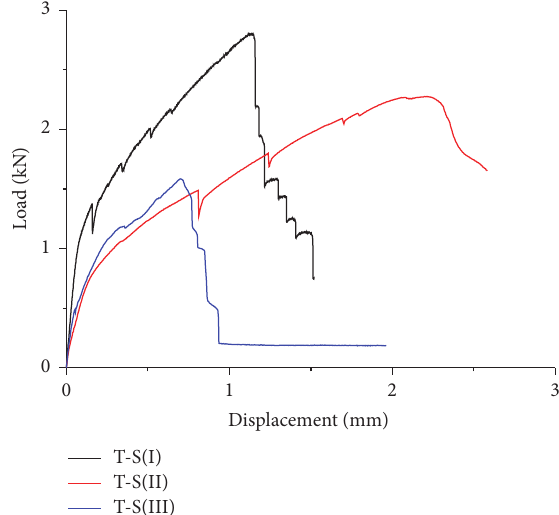
Figure 6: Load-displacement curves of specimens